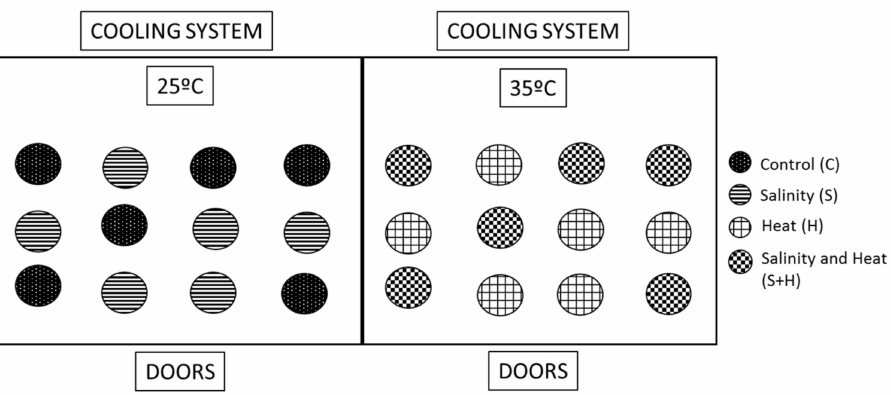
Figure 1. Experimental design layout of the greenhouse container experiment using a completely randomized design (CRD) with four treatments, control (C), saline (S) and heat conditions (H) and the combination of salinity and heat (S + H), and six replicates per